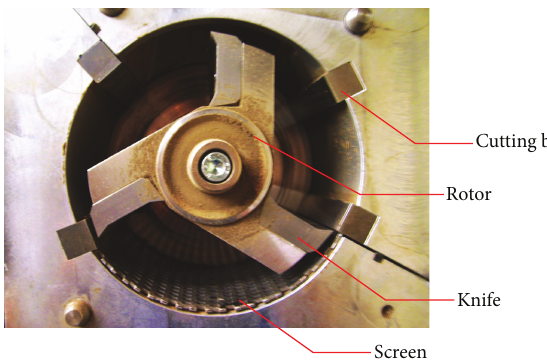
Figure 5: Milling chamber of the knife mill.